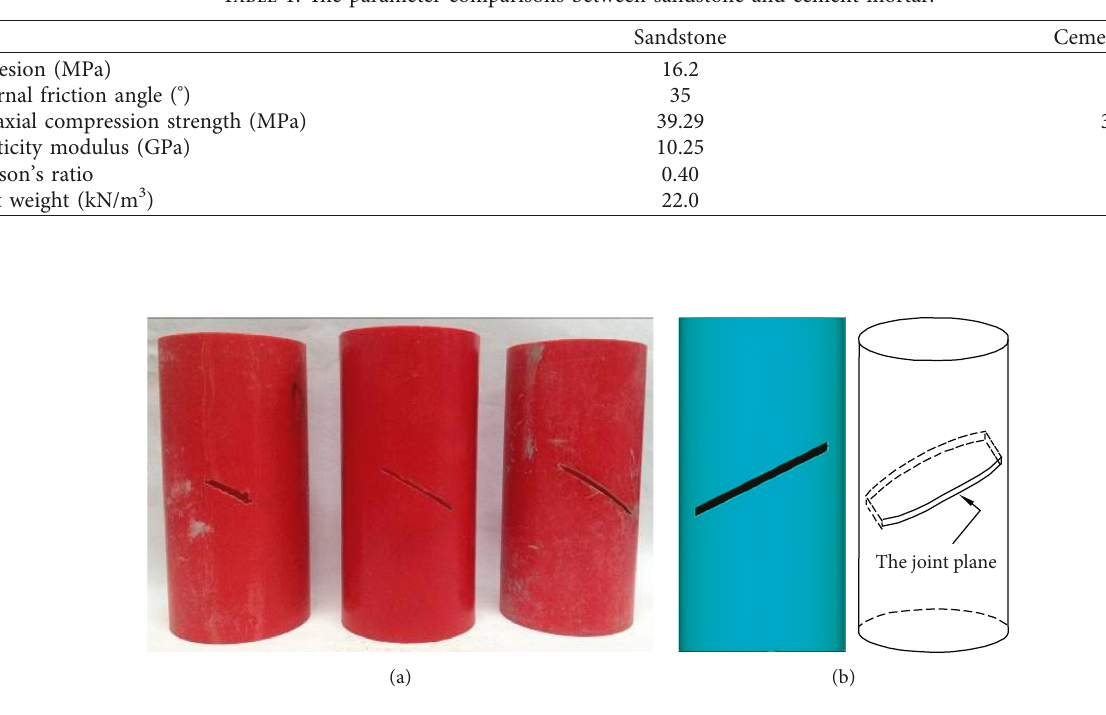
Figure 2: Schematic diagram of specimens. (a) Cylindrical plastic molds used for sample preparation. (b) Joint location and joint connectivity